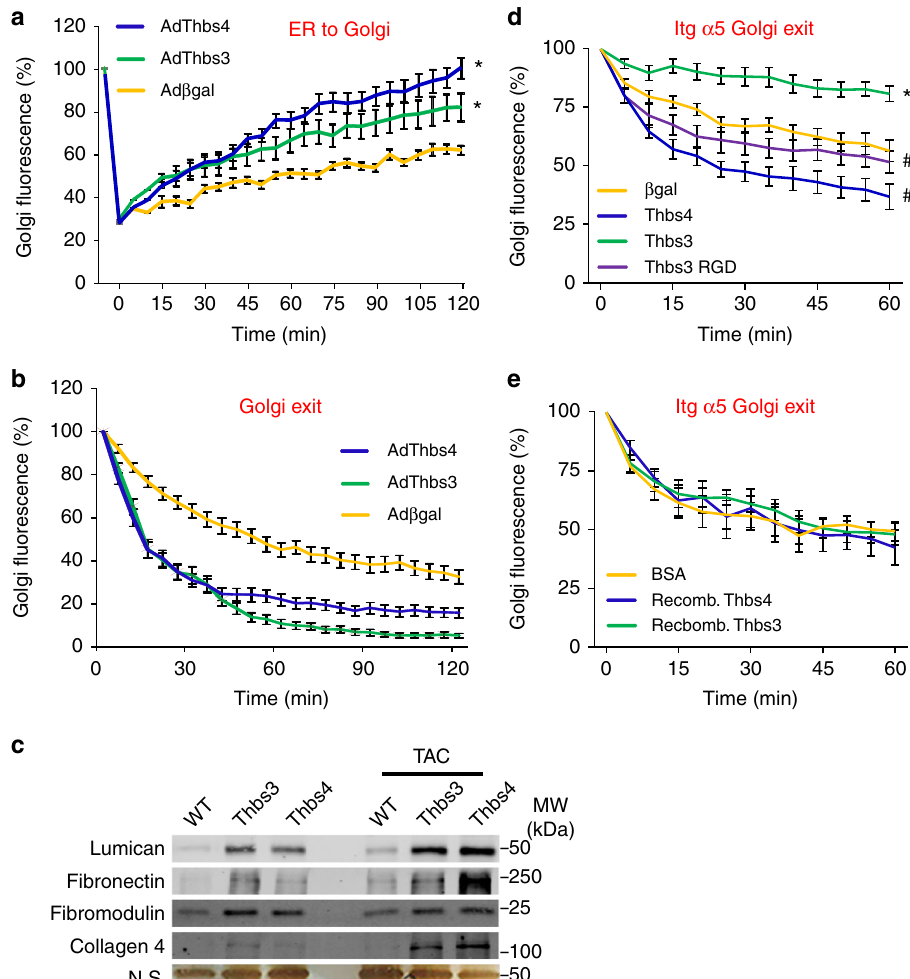
Fig. 7 Thbs3 enhances secretory pathway activity but reduces membrane integrins. a Time course of intracellular traf fi cking fl uorescence changes in cultured neonatal ventricular cardiomyocytes (NRVMs) infected with a GalNac-T2-RFP baculovirus and the indicated adenoviruses. The data show a quantitative time course of GalNac-T2-RFP recovery in the Golgi network after FRAP to measure ER-to-Golgi vesicular traf fi cking. * P < 0.05 versus Ad β gal infected cells. b Quantitative time course of loss of VSVG-eGFP fl uorescence in the Golgi after iFRAP as a measurement for Golgi-to-membrane (Golgi exit) vesicular traf fi cking. * P < 0.05 versus Ad β gal infected cells. Statistical analysis was performed using two-way ANOVA and Turkey